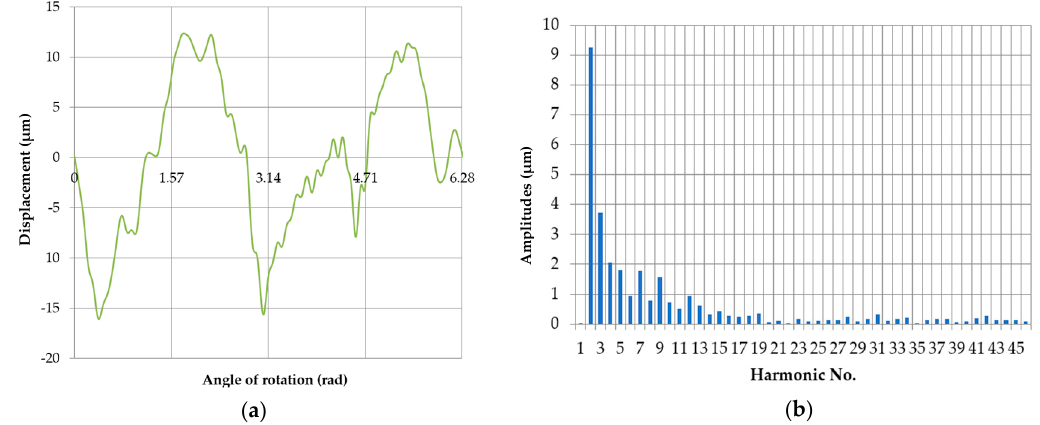
Figure 17. Roundness profile of journal no. 5 measured by the reference method ( a ); the discrete amplitude spectrum ( b ). Table 4. Amplitudes of the harmonic components for the roundness profile of journal no. 5, measured by the reference method.